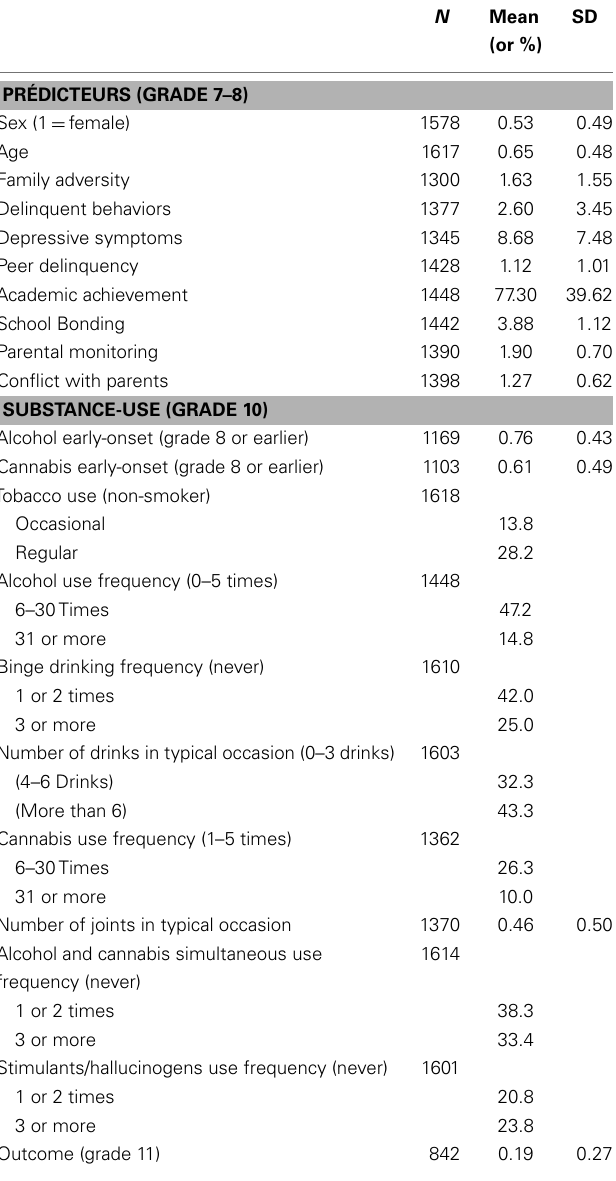
Table 1 | Descriptive statistics for substance-use variables, predictors, and